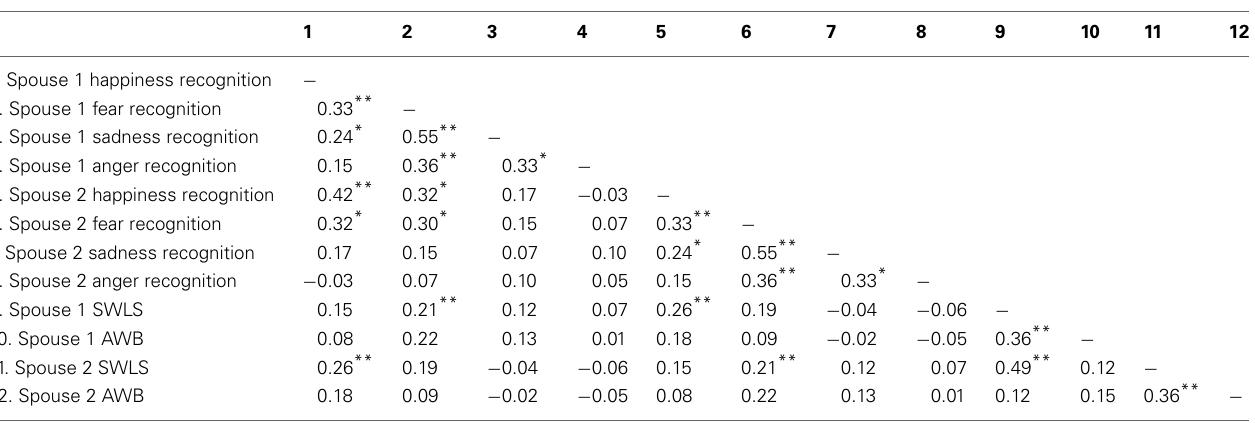
Table 3 | Intercorrelations among the Study 1 measures.